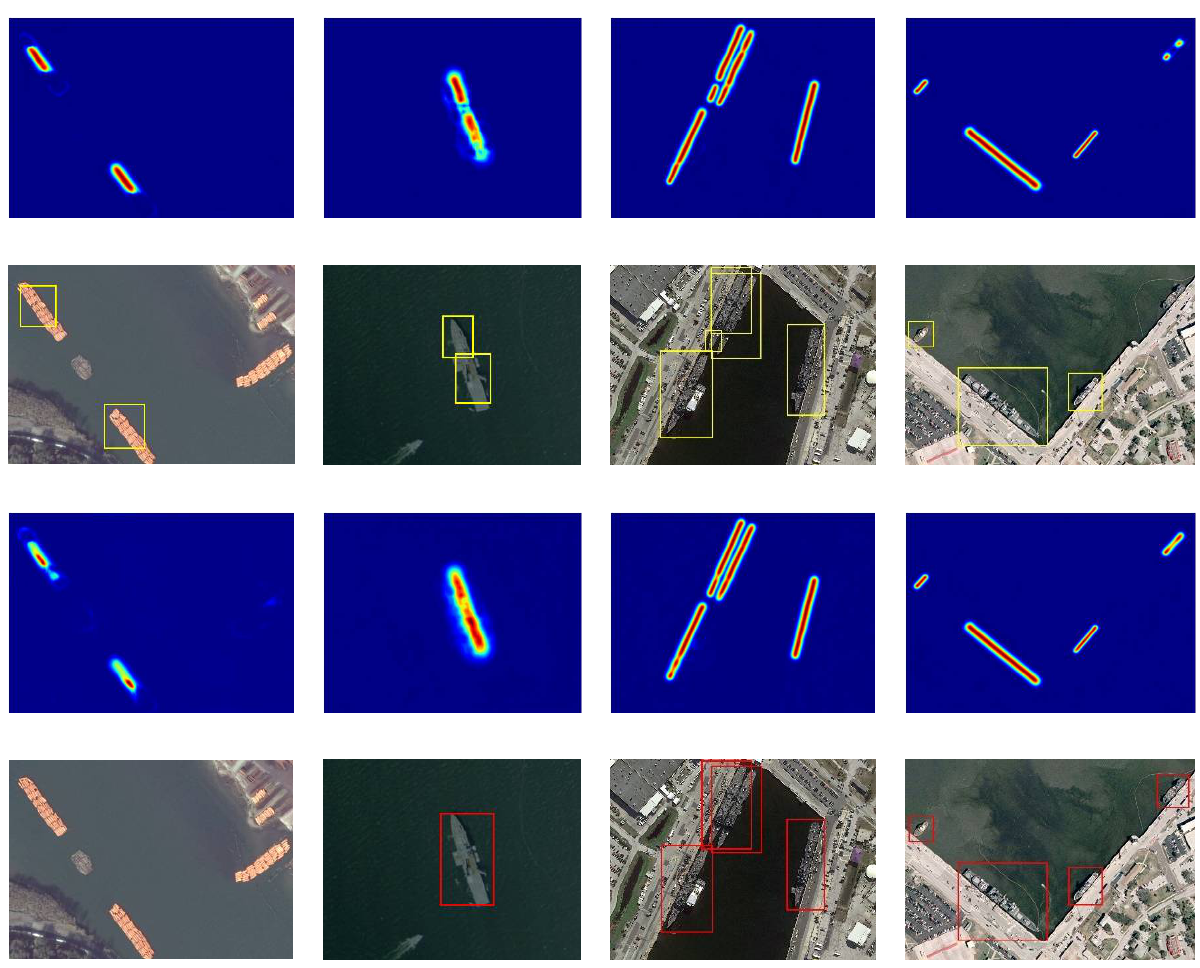
Figure 13. Examples of better results after using TTA. From top to bottom, the first and second rows represent the ship feature maps and polygon annotations obtained without using TTA, and the third and fourth rows represent the ship feature maps and polygon annotations obtained after using TTA.